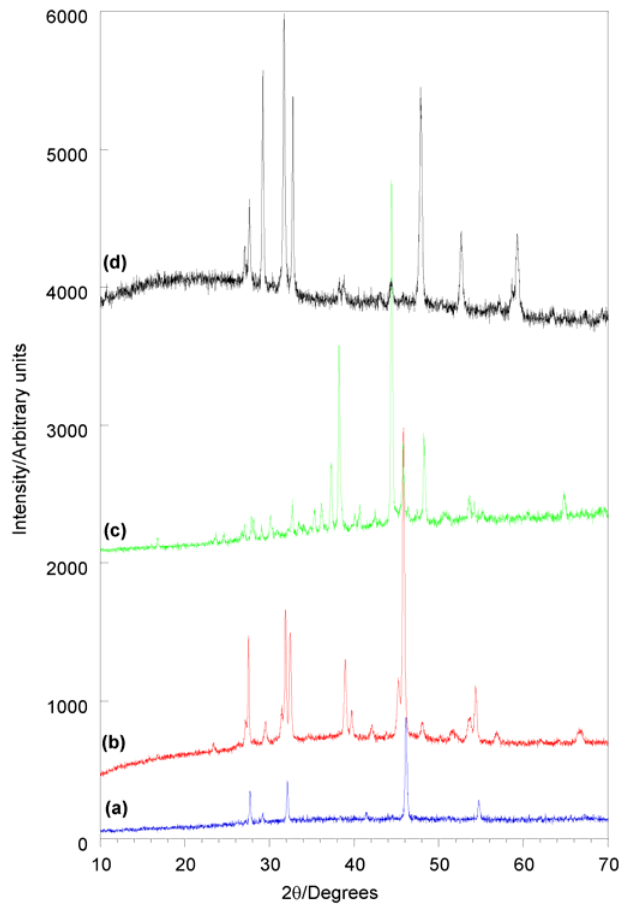
Figure 7. X-ray diffraction patterns of (a) a digenite sample prepared in CHCl (b) a mixture of digenite and tetragonal chalcocite prepared by heating the sample in (a) to 400 °C for 5 h, (c) a monoclinic chalcocite sample prepared by heating the sample in (a)